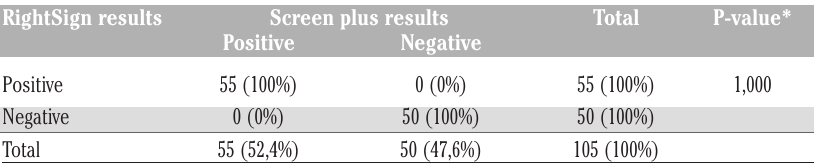
Table 9. Comparison of ScreenPlus and RightSign.